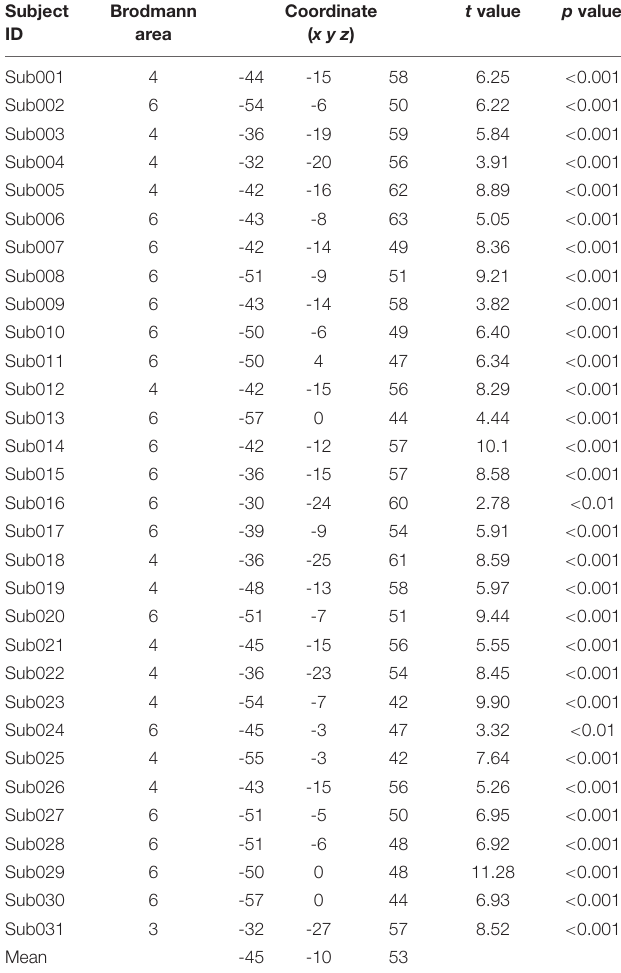
mean age ± SD: 23 ± 2.8 years). All participants met